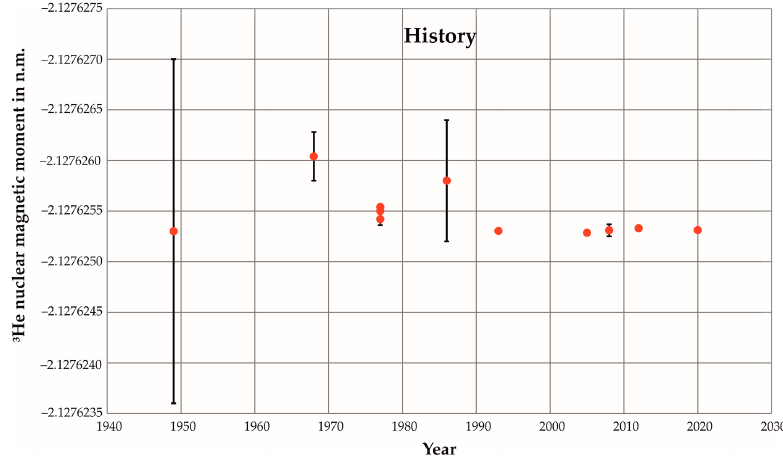
Figure 2. The nuclear magnetic moment of 3 He measured by the NMR